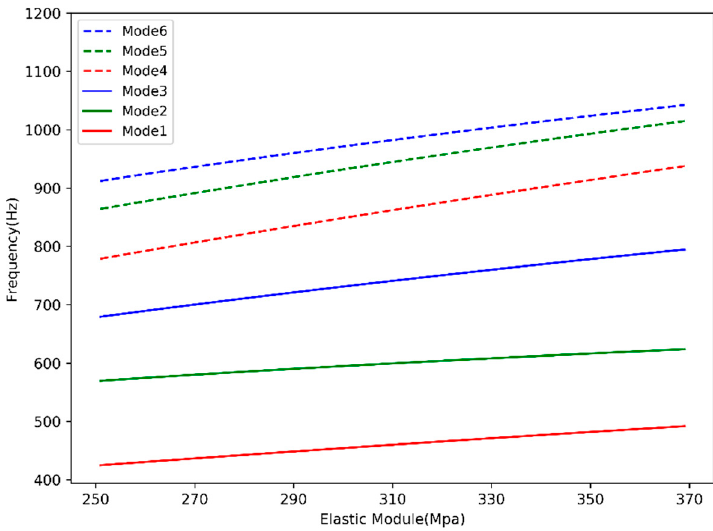
Figure 11. The natural frequency of each mode of the battery module increased linearly with the increase of the equivalent elastic modulus.